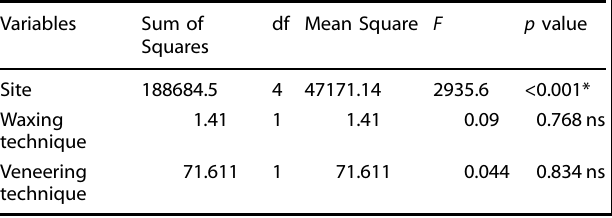
Table 2. Effect of the different variables on internal gap width (µm).